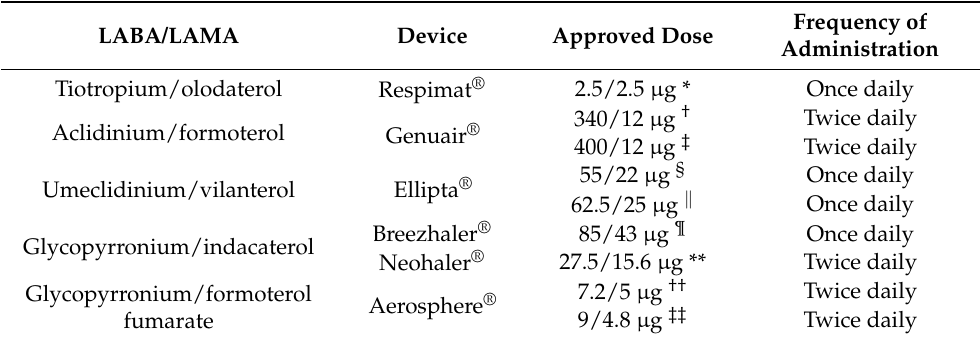
Table 1. Fixed-dose combinations of LABAs and LAMAs currently approved for COPD treatment [12]. Frequency of LABA/LAMA Device Approved Dose Administration Tiotropium/olodaterol Respimat ® 2.5/2.5 µ g * Once daily 340/12 µ g † Twice daily Aclidinium/formoterol Genuair ® 400/12 µ g ‡ Twice daily 55/22 µ g § Once daily Umeclidinium/vilanterol Ellipta ® 62.5/25 µ g (cid:107) Once daily Breezhaler ® 85/43 µ g ¶ Once daily Glycopyrronium/indacaterol Neohaler ® 27.5/15.6 µ g ** Twice daily Glycopyrronium/formoterol Aerosphere fumarate